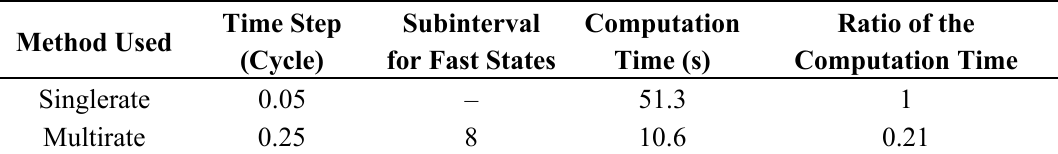
Figure 8. Simulation comparison with single-rate and multi-rate methods: ( a ) Voltage magnitude; ( b ) Angle. Table 5. Computational time